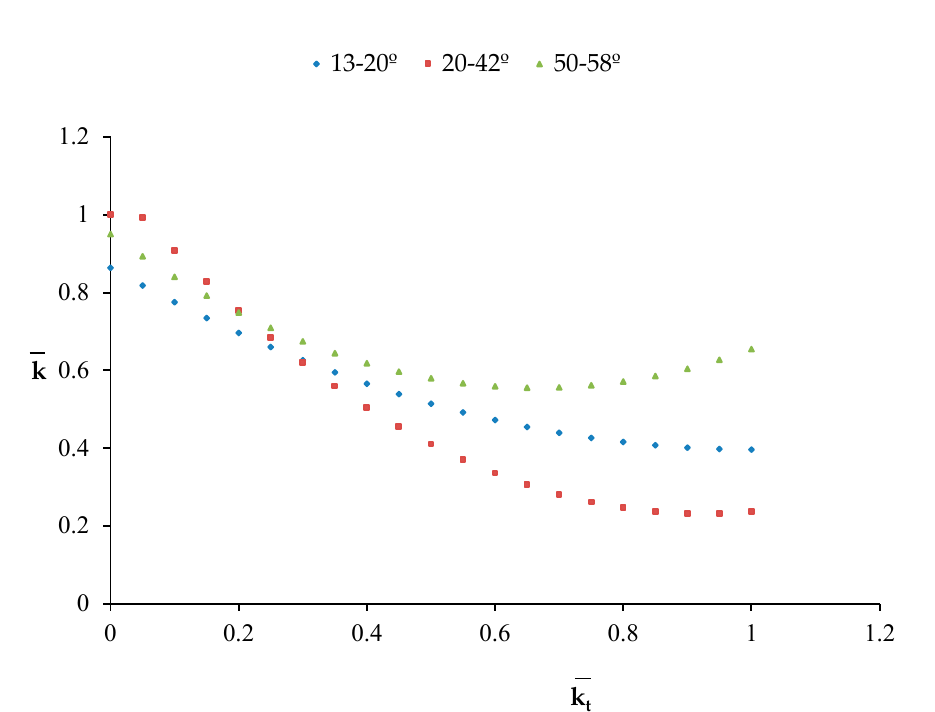
Figure 12. Regression curves and equations.